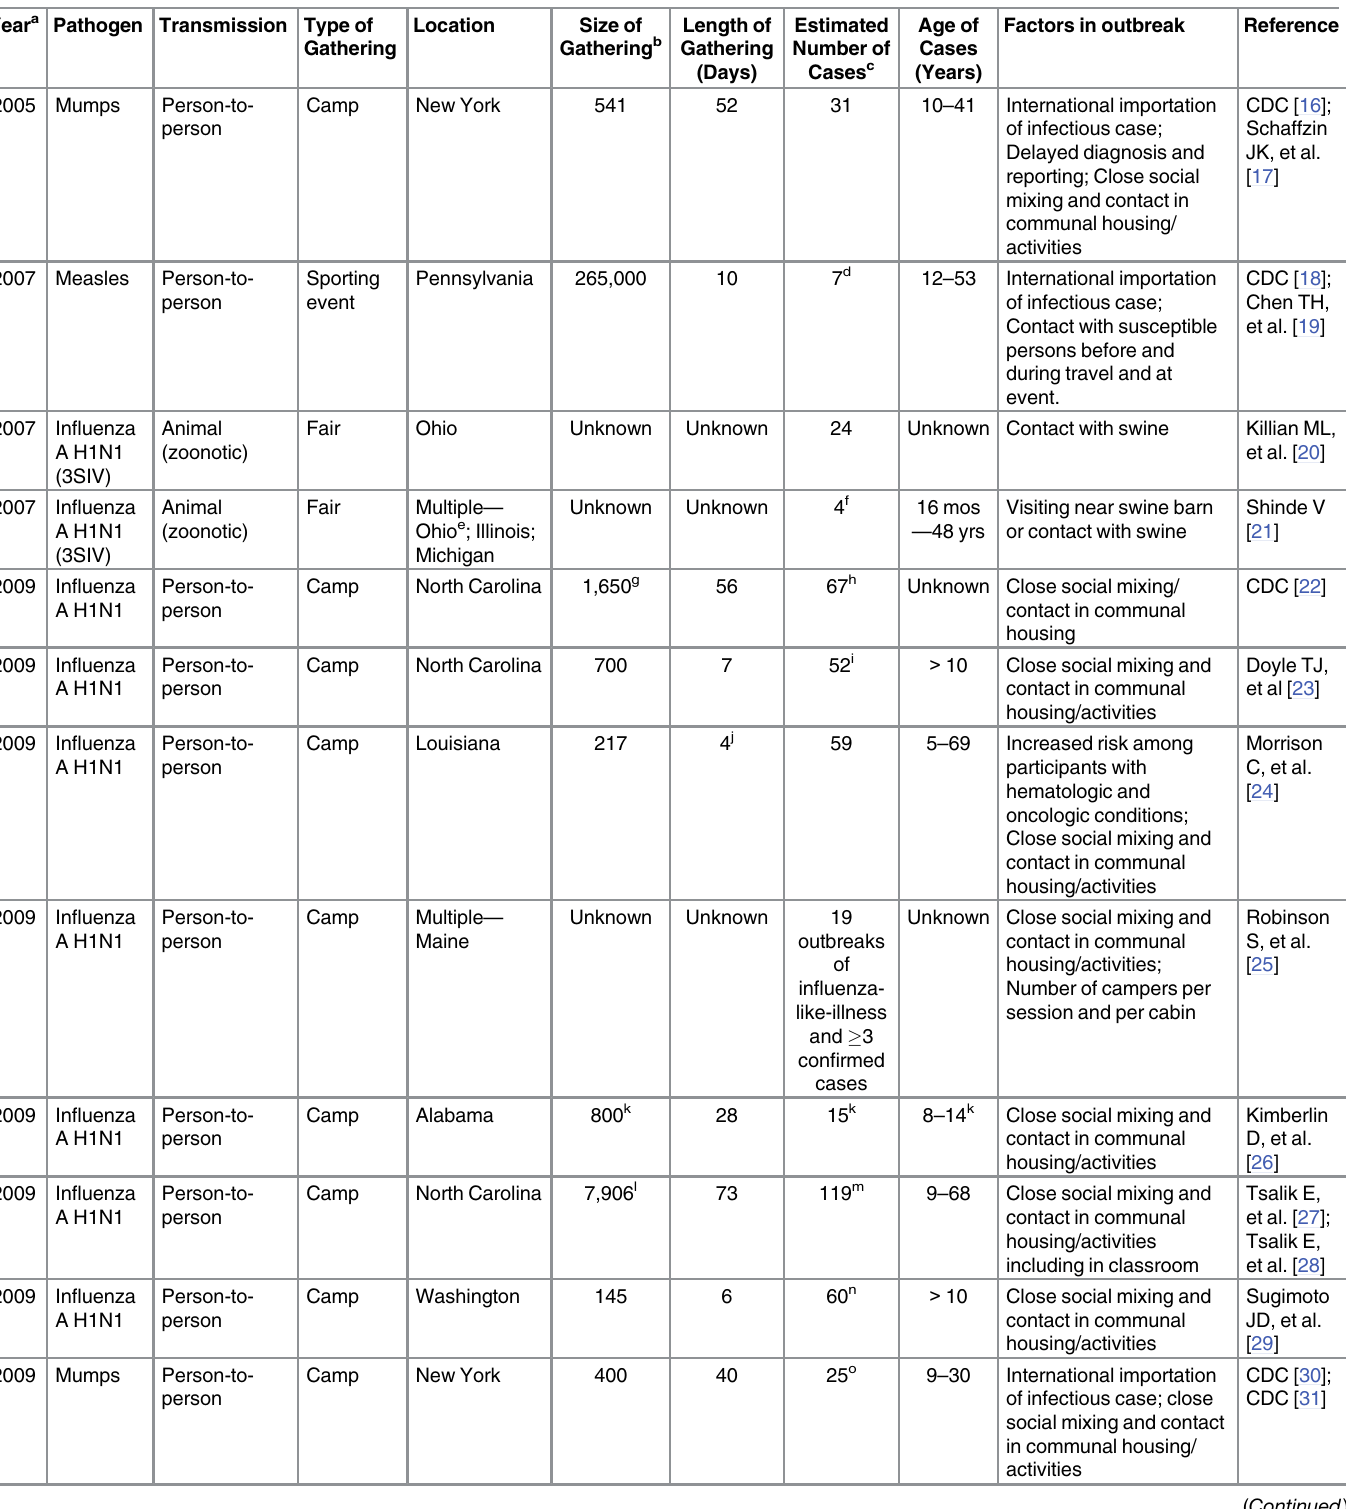
Table 2. Relevant articles about mass gathering-related respiratory disease outbreaks listed by year of outbreak and pathogen, identified from a literature review of articles published during 2005 and